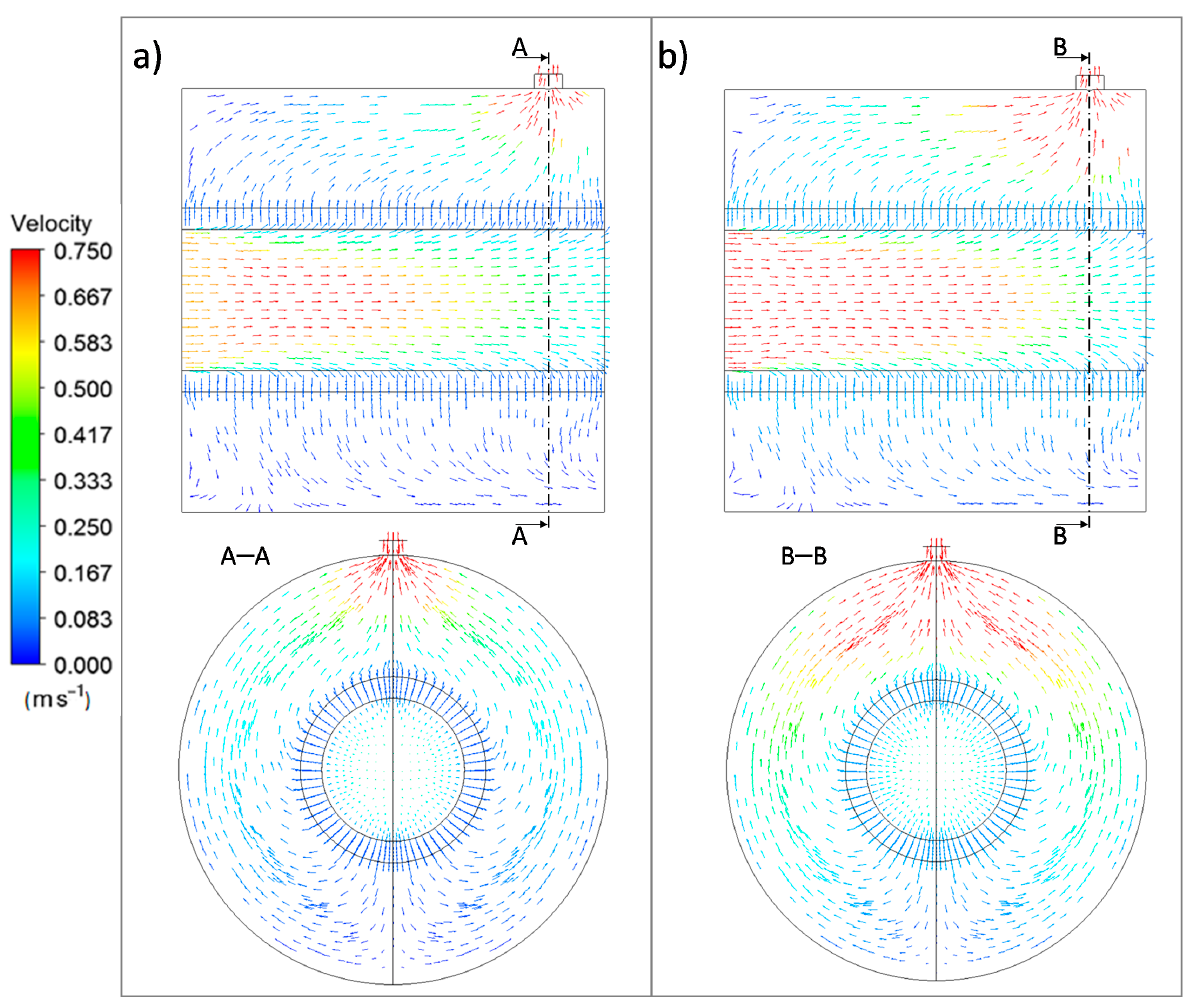
Figure 4. Velocity vectors for nitrogen permeation at 298 K through the PSS support (in–out configuration) at diverse pressure driving forces: ( a ) 0.5 bar and ( b ) 1.0 bar.